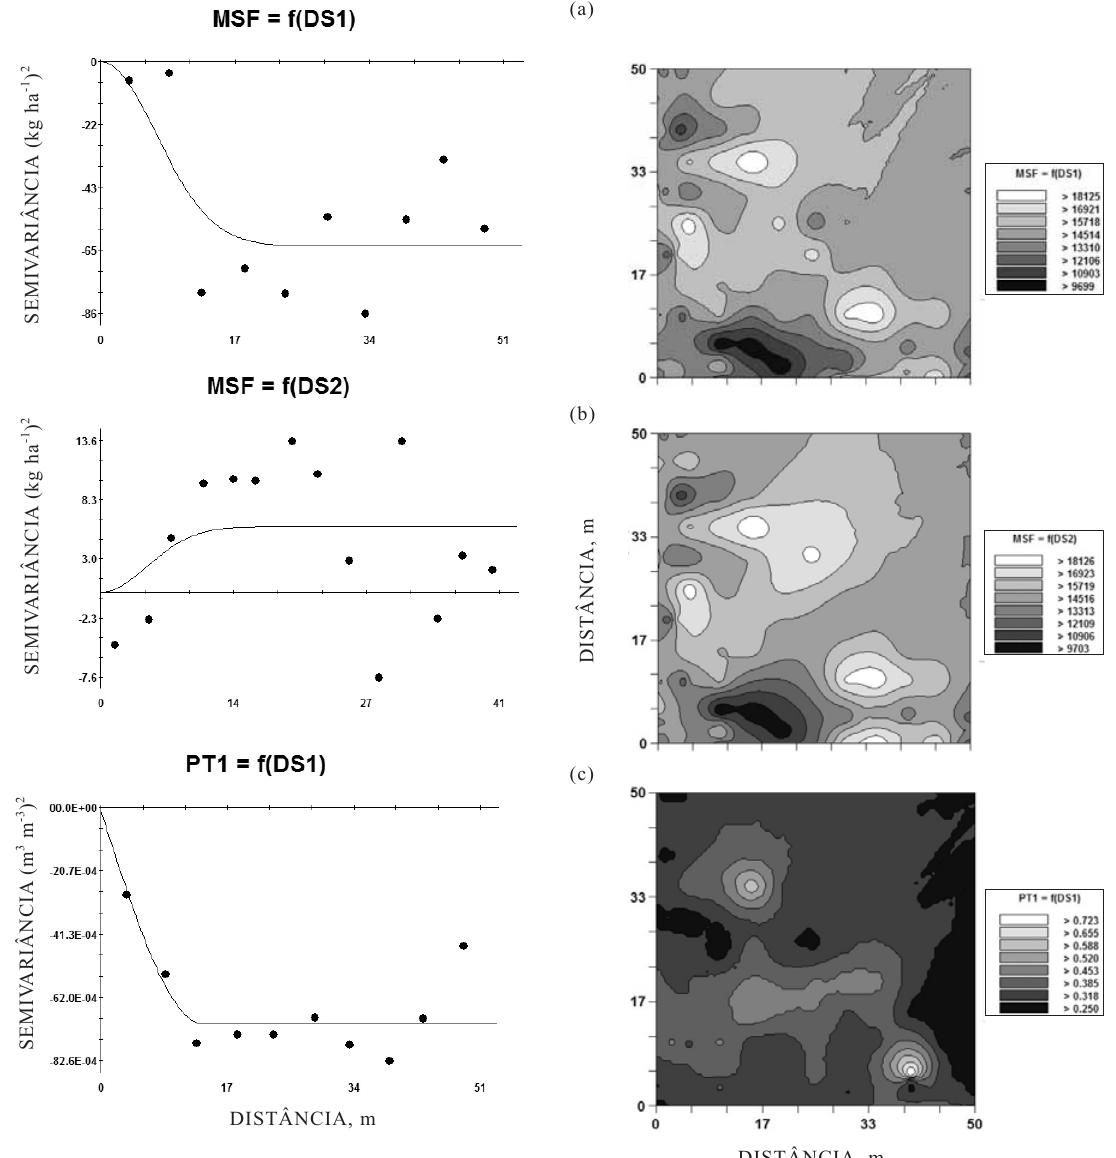
Figura 2. Semivariogramas e mapas de co-krigagem da produtividade de matéria seca da forragem do milho em função da densidade (DS1 e DS2) e da porosidade total (PT1) em função da densidade (DS1) de um Latossolo Vermelho distrófico de Pereira Barreto